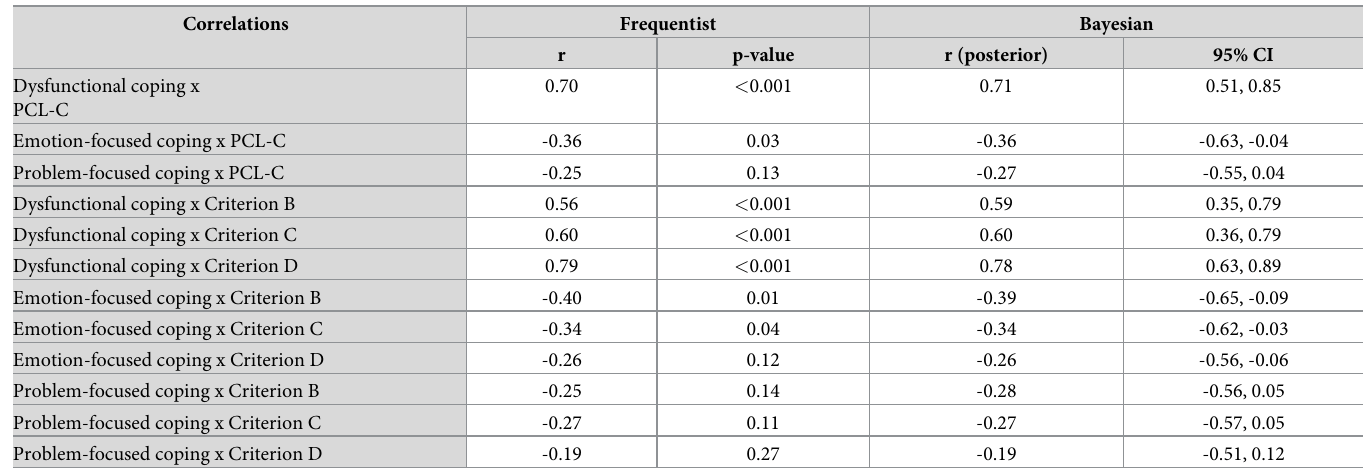
Table 6. Comparison between correlation coefficients of frequentist and Bayesian analysis.